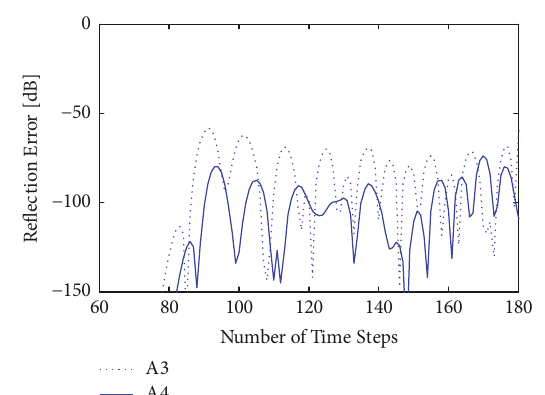
Figure 9: Reflection error as a function of time step for Example